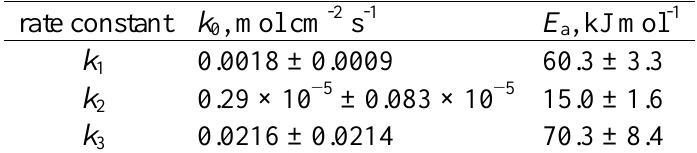
Table 1. Arrhenius kinetic parameters for Equation (10)